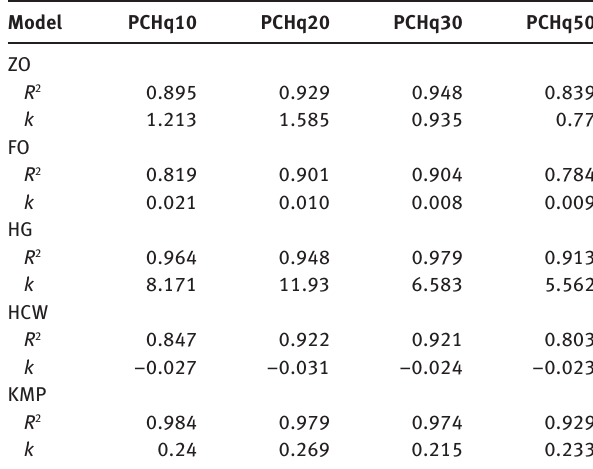
Table 4: Parameters of regression equation reflected Hq released process from the PCHq nanoparticles in pH 7.4 solution according to different kinetic models.